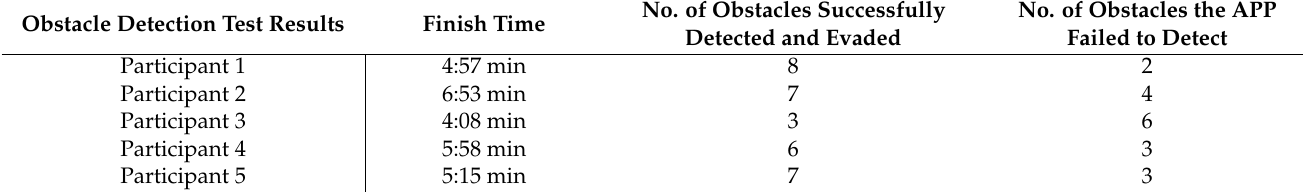
Table 4. Obstacle detection evaluation with finish score, successfully detected and evaded, and detection fails of the application.